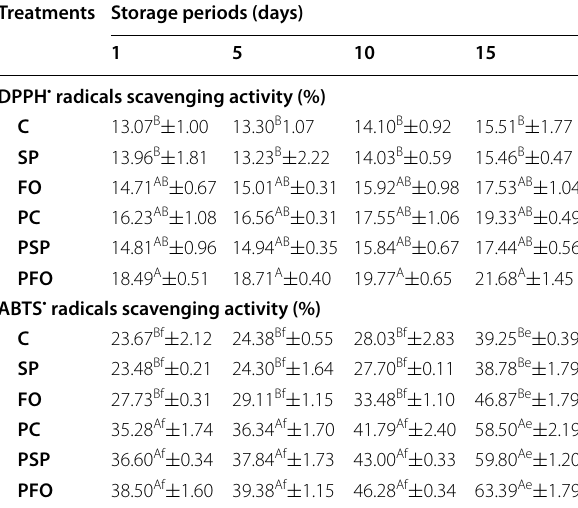
A,B letters within the same column differ significantly at P <0.05; e,f letters within the same row differ significantly at P <0.05; C, yoghurt made from ewes’ milk fed a control diet; SP, yoghurt made from ewes’ milk fed Spirulina platensis ; FO, yoghurt made from ewes’ milk fed fish oil; PC, probiotic yoghurt made from ewes’ milk fed a control diet; PSP, probiotic yoghurt made from ewes’ milk fed Spirulina platensis ; PFO, probiotic yoghurt made from ewes’ milk fed fish oil